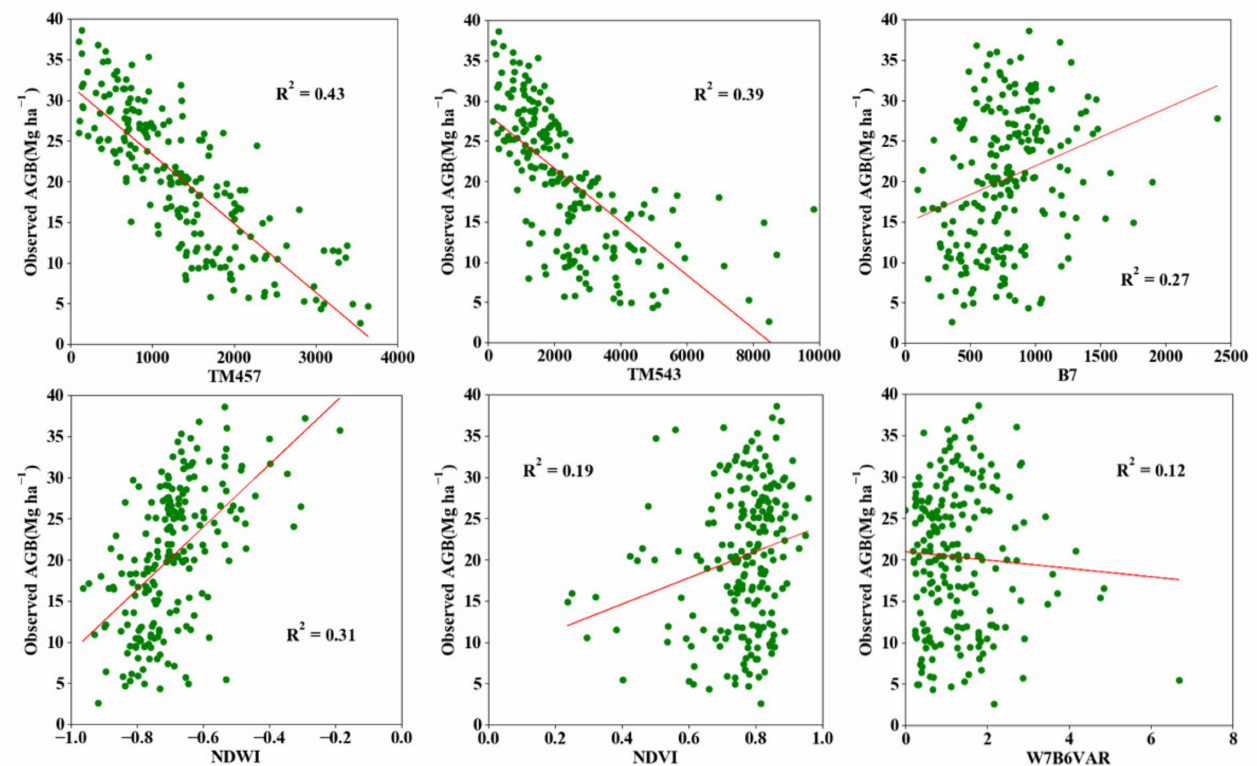
Figure 12. Correlation between selected variables and bamboo forest AGB. Figure 13 further analyzes the correlations of the top 20 variables of